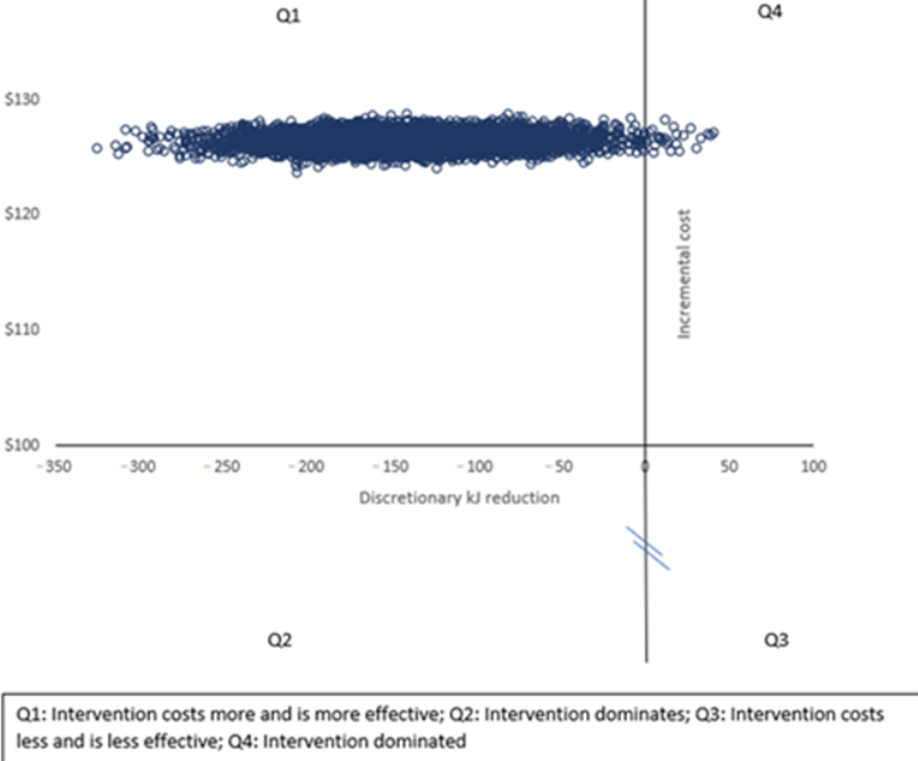
Figure 1. Cost–effectiveness plane for reduction in lunchbox energy from discretionary foods.